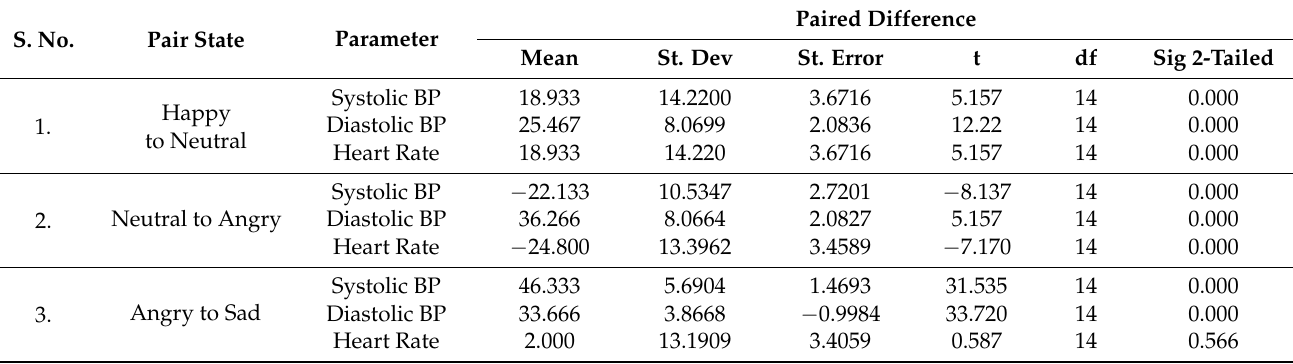
Table 14. Paired-sample t -test parameters for